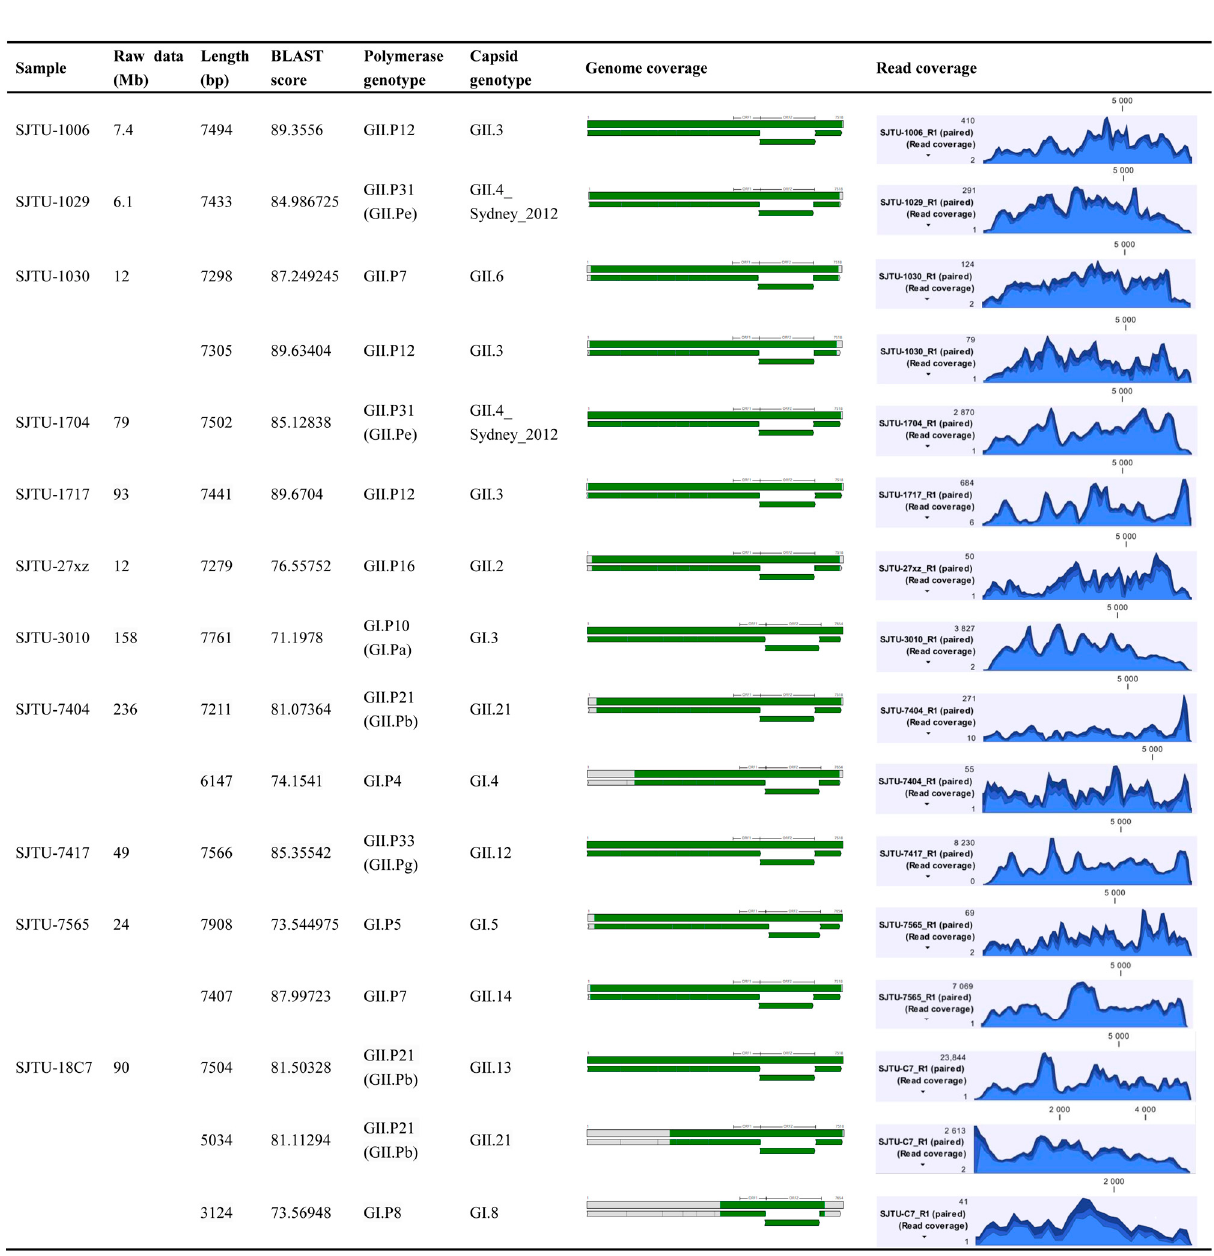
Figure 2. Detailed sequencing results of HuNoVs positive samples using TRACE-seq. Results were analyzed by each sample. Sequences which could be genotyped by polymerase and capsid are listed. In the genome coverage column, sequences obtained in this study that matched the reference sequence of HuNoVs are shown in green. In the last column, altitude indicates the reads coverage in each position of obtained sequences.